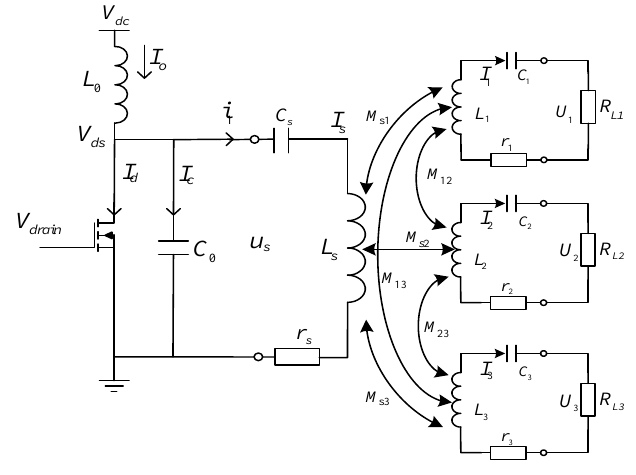
Figure 2. The circuit model of three-coils-receiver